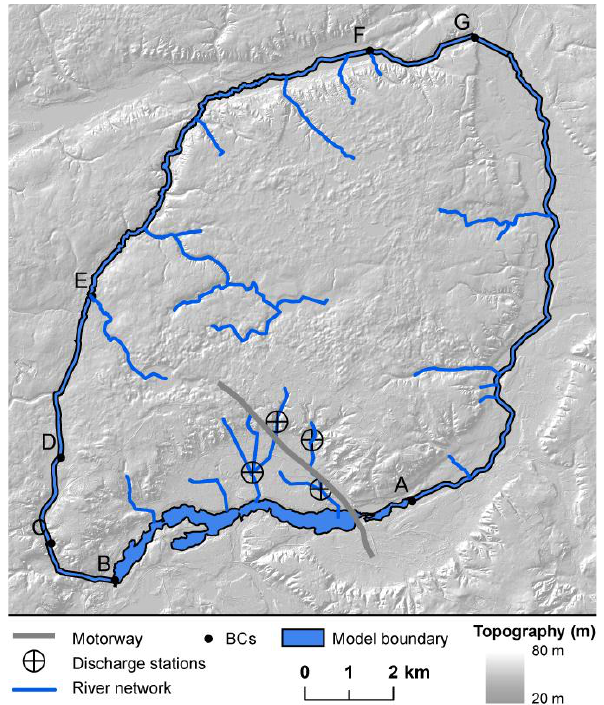
Fig. 4. Local model set-up. Model boundary (section A–G), MIKE Figure 4 Local model setup. Model boundary (section A-G), MIKE 11 river network, discharge stations (Q), and 2 11 river network, discharge stations ( Q ), and topography. Model topography. Model area is 103 km 2 . 3 area is 103km 2